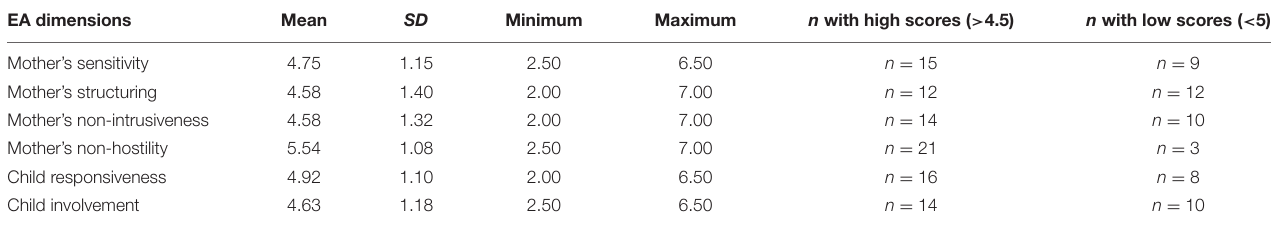
TABLE 2 | Mean scores of the Emotional Availability Scales (EAS) and standard deviations ( SD ) of N = 24 mother–child dyads as well as subsample sizes of the generated groups for ANCOVA. EA dimensions Mean